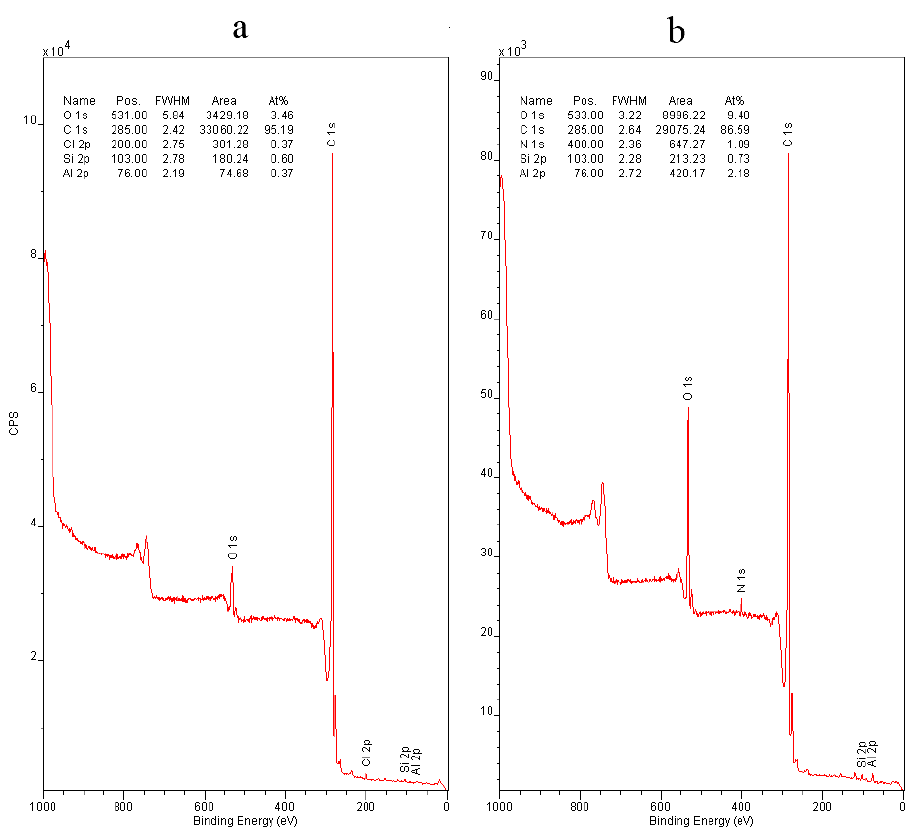
Figure 8. Survey X-ray photoelectron spectra. ( a ) Initial MWCNTs/Al sample. ( b ) Oxidized MWCNTs/Al sample.